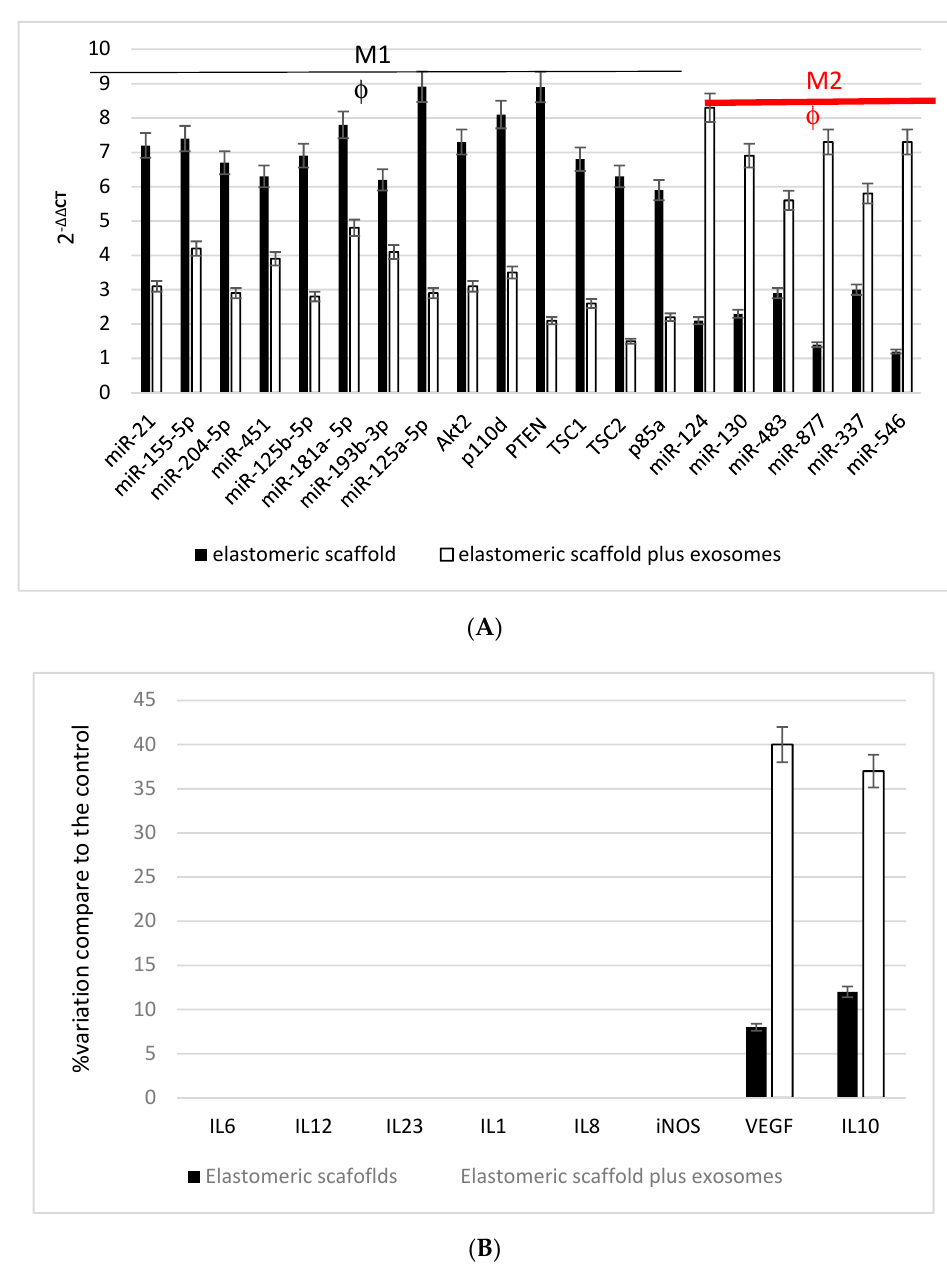
Figure 6. ( A ) semi-quantitative real-time PCR of the mRNA and miRNA levels of macrophages on elastomeric fibers (CTRL) and test conditions (elastomeric fibers plus exosomes) over 2 days of culturing. Data is presented as the mean ± standard error of 3 measurements. p ≤ 0.05. ( B ) semi-quantitative evaluation of protein secretion of macrophages seeded on elastomeric scaffolds and onto elastomeric scaffolds plus